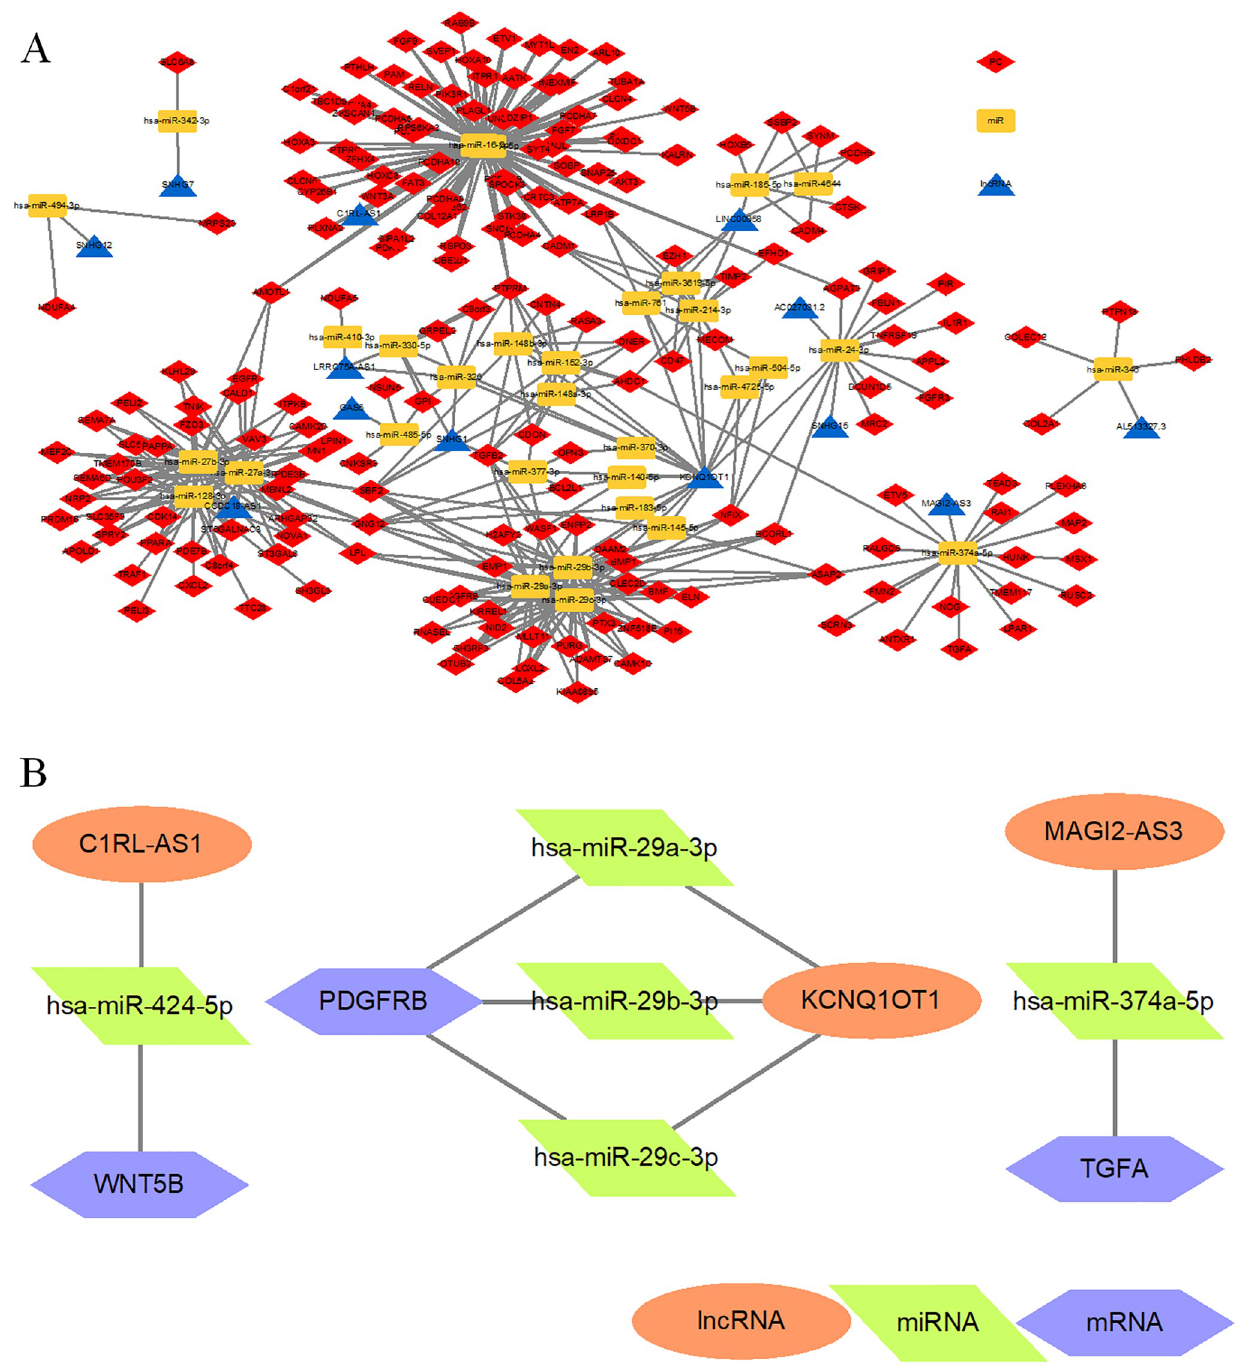
Fig 4. Histogram of KEGG pathway enrichment distribution of DEGs in a ceRNA regulation network. (A). CeRNA network combined with miRNA, lncRNA, and mRNA of primed, naive and EPS cells. (B). CeRNAs were subjected to the prediction of naive-primed related signaling pathways.